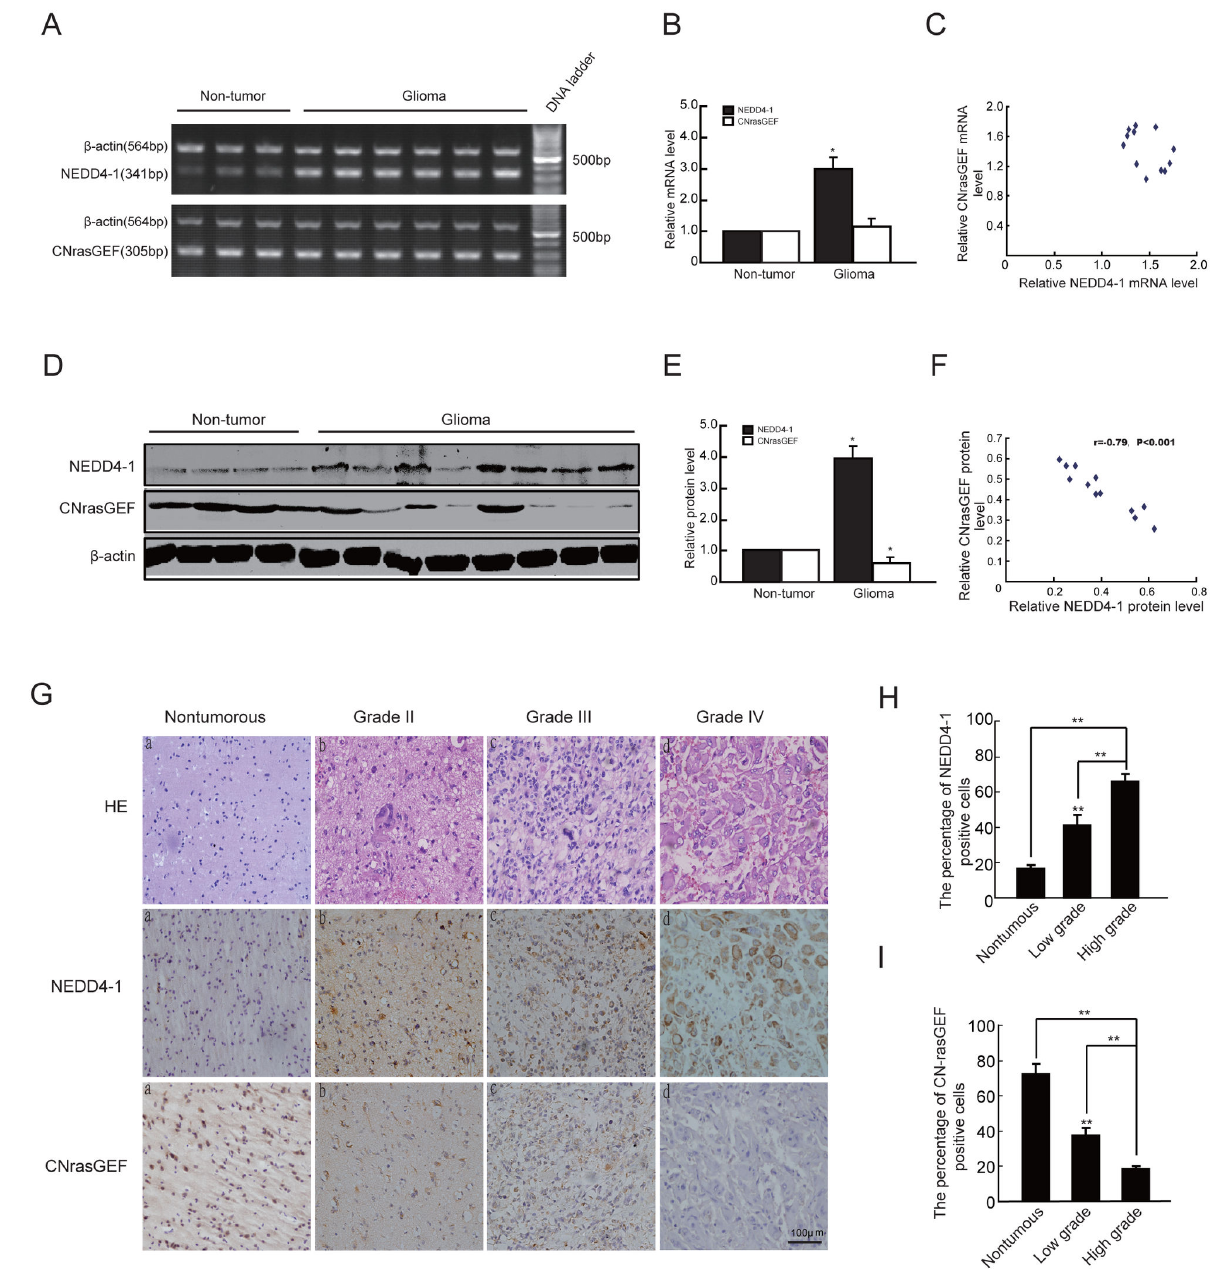
Figure 6. Expression of NEDD4-1 and CNrasGEF in glioma tissues. A) mRNA levels of NEDD4-1 and CNrasGEF in glioma and nontumorous brainspecimens was detected by RT-PCR. B) Quantitative analysis of the mRNA levels of NEDD4-1 and CNrasGEF normalized to those of β-actin. C) The mRNA relationship between the NEDD4-1 and CNrasGEF. D) Western blotting analysis of the total extracts isolated from human nontumorous brain and human glioma specimens using human NEDD4-1 and CNrasGEF antibodies. E) Quantitative analysis of the protein levels of NEDD4-1 and CNrasGEF normalized to those of β-actin. F) The protein relationship between the NEDD4-1 and CNrasGEF. r=-0.79. I) Representative hematoxylin-eosin staining and immunohistochemistry (IHC) analysis of NEDD4-1 and CNrasGEF expression in nontumorous brain tissue and glioma specimens of varying World Health Organization (WHO) grades. Normal brain tissue (a); diffuse astrocytoma, grade II (b); anaplastic astrocytoma, grade III (c); GBM, grade IV (d) are shown. IHC stainings were performed at least twice with similar stained patterns. Scale bar: 100μm. J&K) Quantitativeanalysis of the percentage of NEDD4-1 and CNrasGEF positive cells. Data were derived from three independent experiments. ** P <0.01 vs nontumorous. doi: 10.1371/journal.pone.0082789.g006 PLOS ONE |